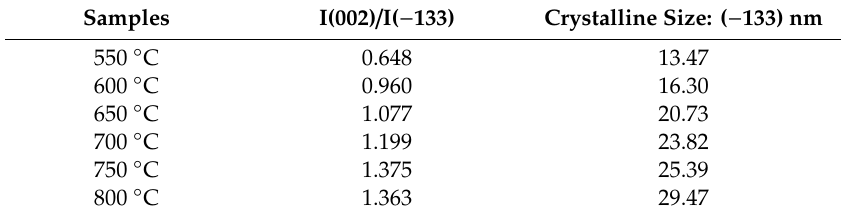
Table 3. Cell parameters for pure samples at di ff erent calcination temperatures.